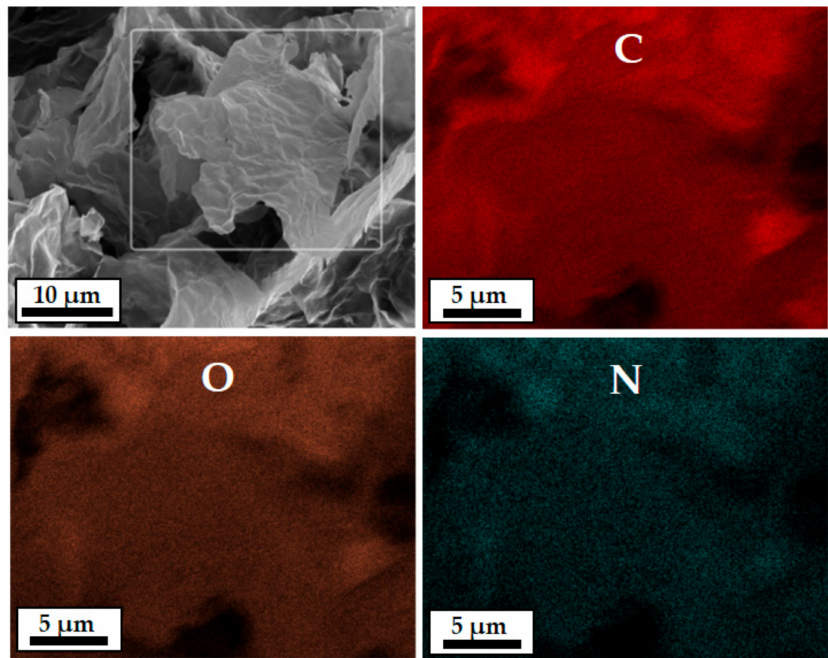
Figure 4. SEM–energy dispersive X-ray (EDX) mapping images showing the distribution of carbon (C), oxygen (O), and nitrogen (N) of